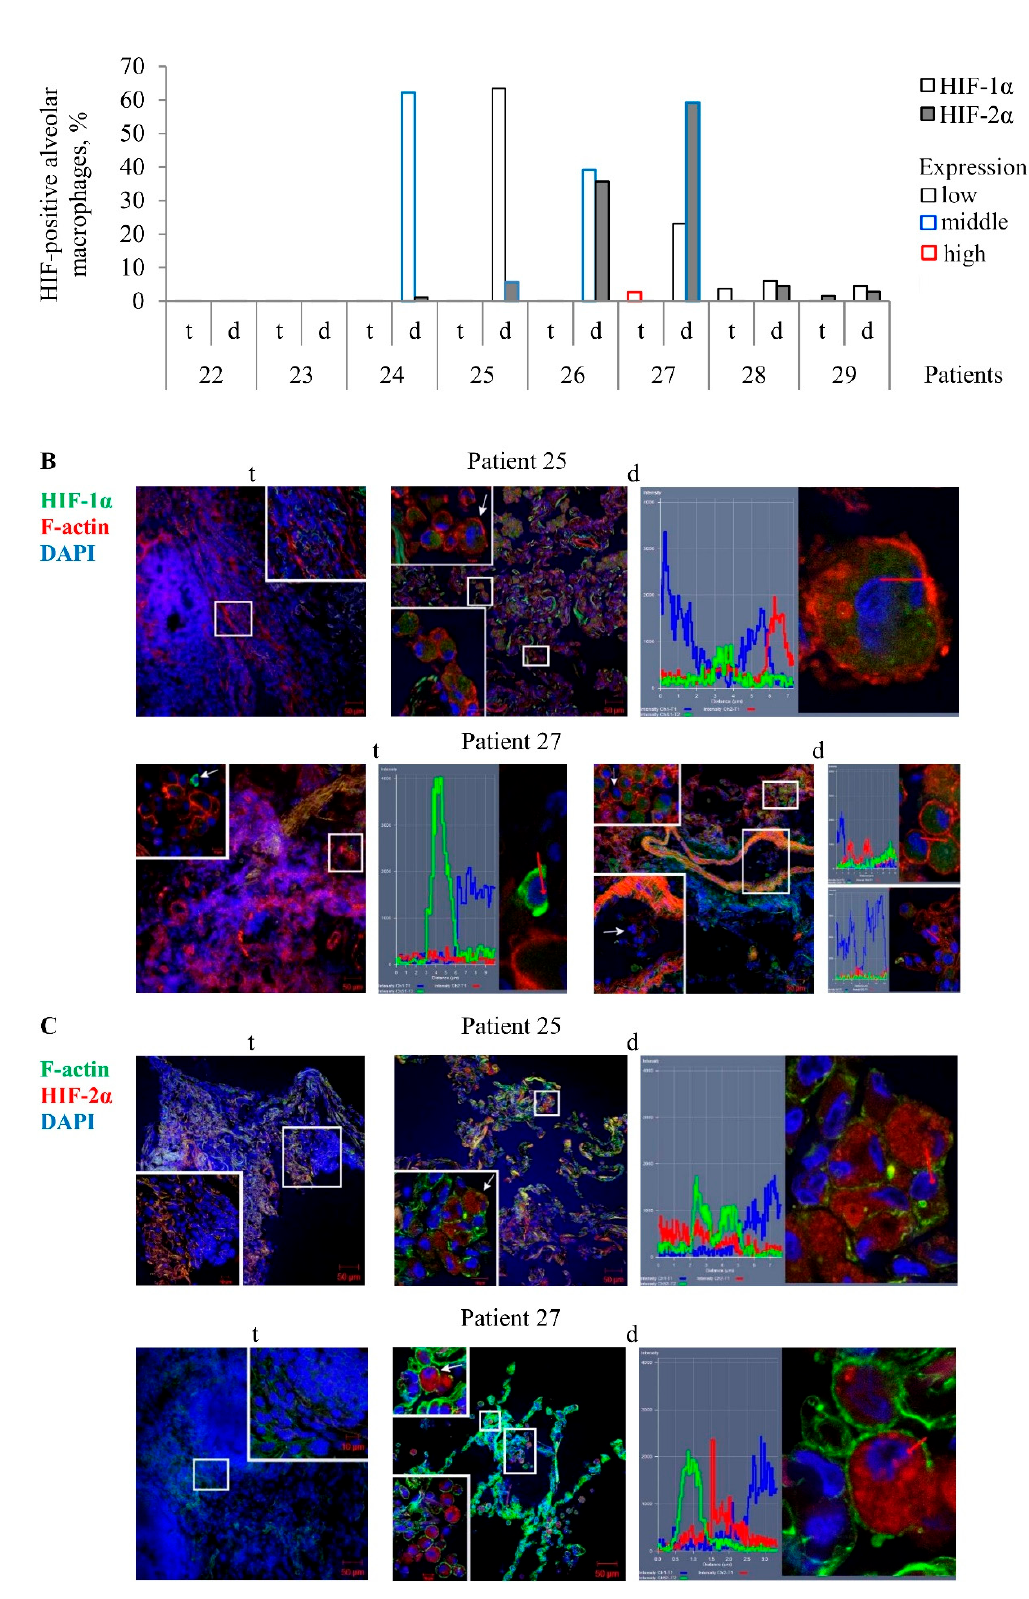
Figure 2. Alveolar macrophages with the transcription factors HIF-1 α and HIF-2 α accumulated in them are mainly detected on the histological sections obtained from the lung tissues distant from tuberculomas (d), but not from tuberculoma walls (t) for some TB patients. ( A ) The number of alveolar macrophages with the HIF-1 α and HIF-2 α isoforms expressed as the percentage of the total number of the TB patients’ alveolar macrophages analyzed. The expression of the markers is